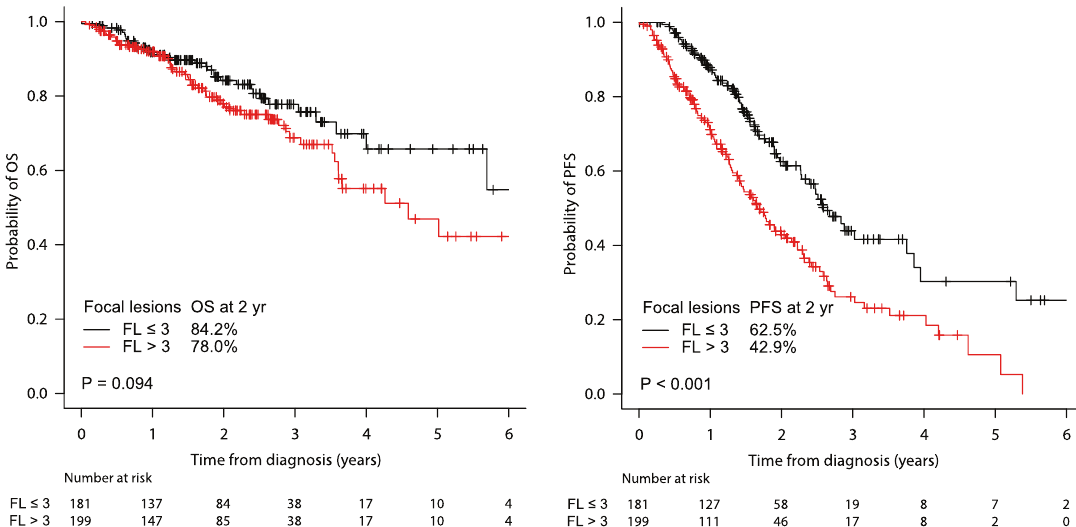
Fig. 1 Survival rates according to the number of focal lesions on PET/CT. A Overall survival rates and B progression-free survival rates according to the focal lesions on PET/CT. Abbreviation: PET/CT positron emission tomography/computed tomography, FL focal lesions, OS overall survival, PFS progression-free